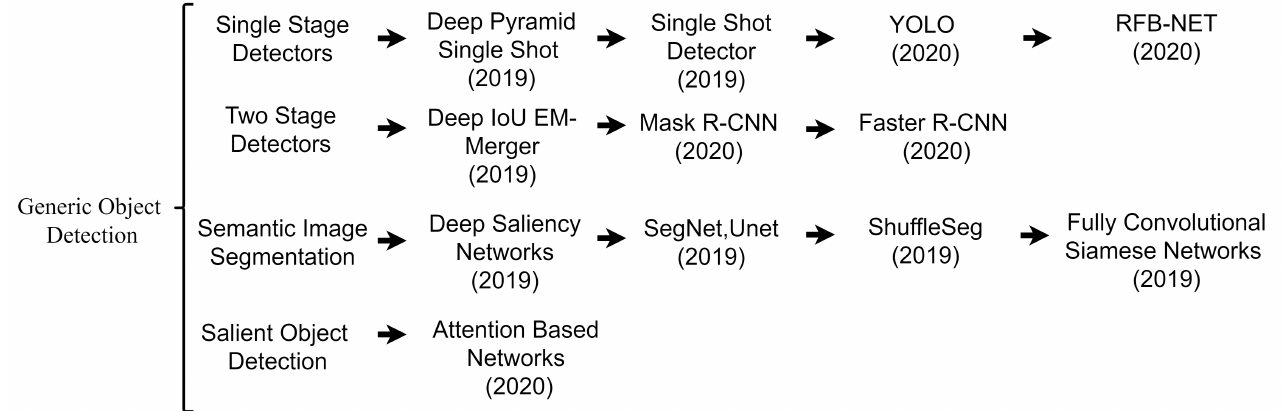
Figure 6. Different object detection algorithms approaches are categorized into four categories. One-stage detectors are fast but lack accuracy, whereas two-stage detectors are slow but accurate. Semantic image segmentation deals with pixel-level detection, and salient object detection deals with detecting objects by applying an attention mechanism.